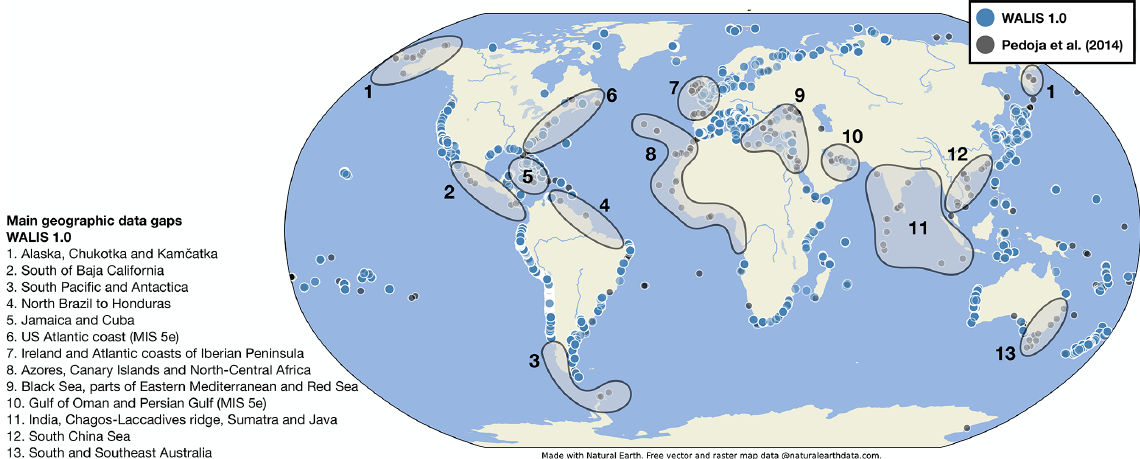
Figure 12. Comparison between sea-level proxies in WALIS 1.0 and those in the global review by Pedoja et al. (2014), indicating areas where geographic data gaps are present (see details in the main text). Map made with Natural Earth, background from https://www.naturalearthdata. com (last access: 15 December